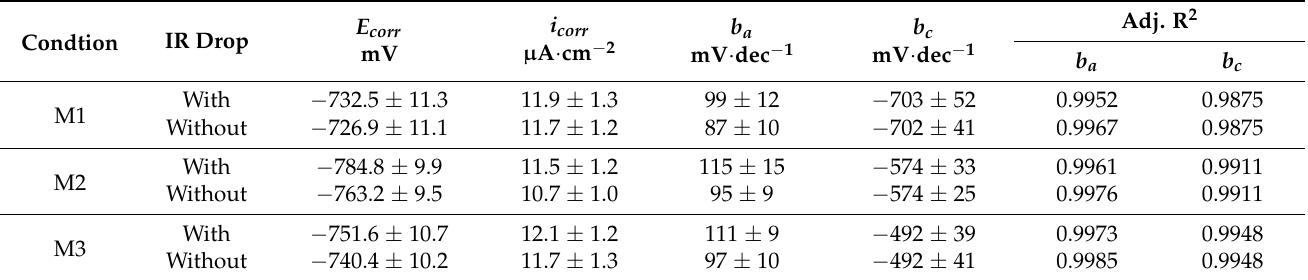
Table 5. Fitting results of polarization curves with and without an IR drop by Tafel extrapolation under three measurements in NaCl solutions after exposure for 2 h.